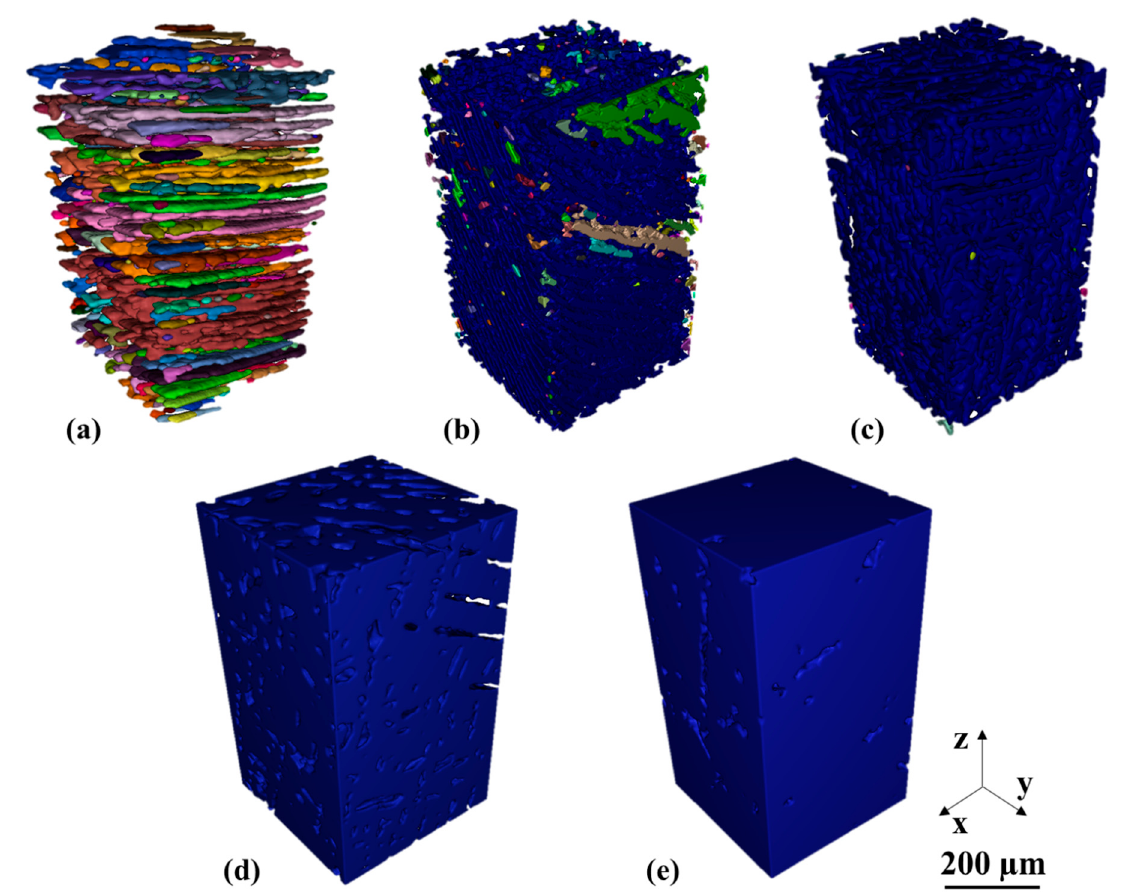
Figure 3. Segmented eutectic phase obtained from µ-XCT. Color code: Each color represents a single connected phase. ( a ) Sn-20 wt.% Bi ( b ) Sn-30 wt.% Bi ( c ) Sn-35 wt.% Bi ( d ) Sn-47 wt.% Bi ( e ) Sn-58 wt.% Bi.